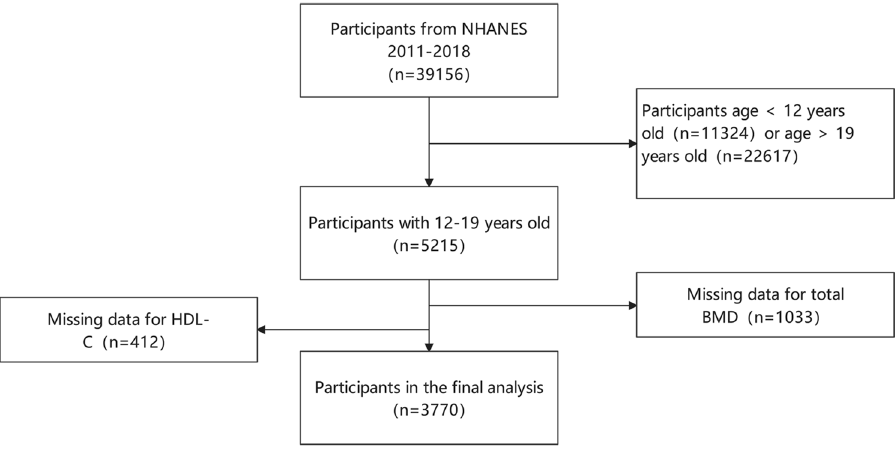
Figure 1. Workflow diagram of samples extraction from the NHANES